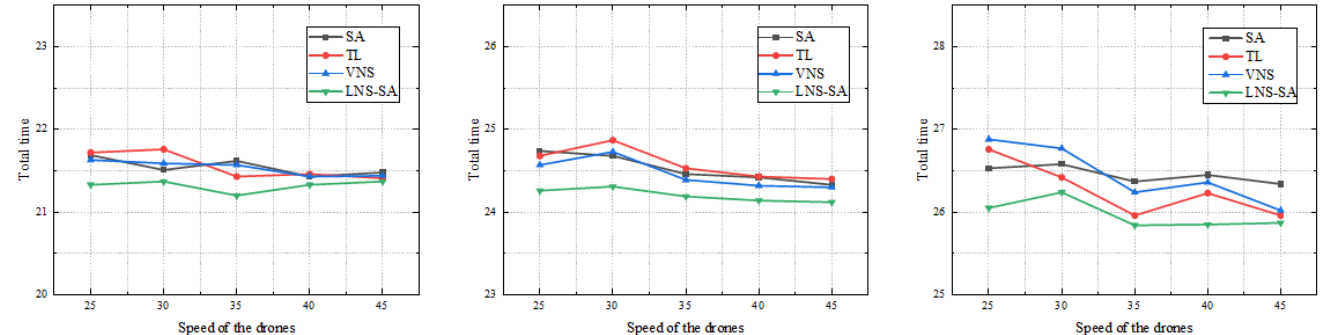
Figure 11. Comparison of results at different drone speeds.